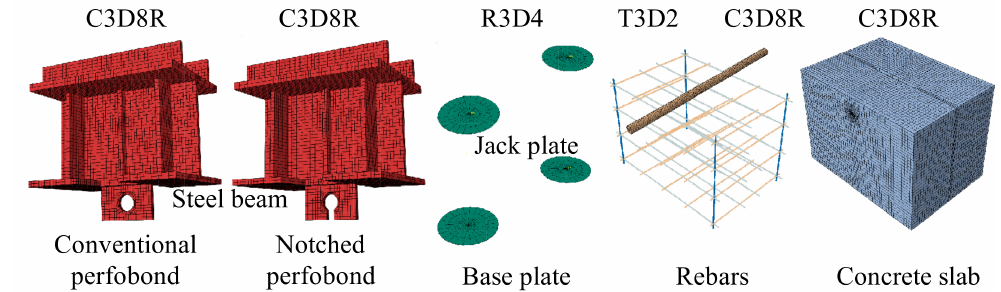
Figure 8. Finite element type and mesh.